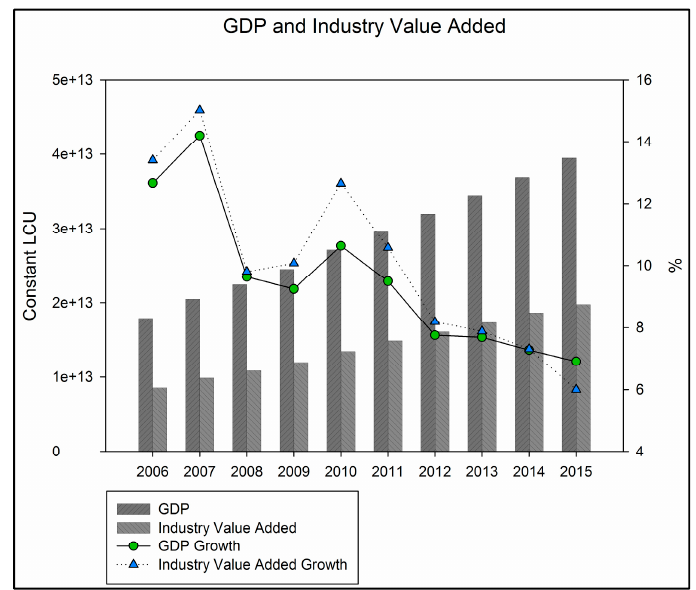
Figure 1. GDP and industry value-added in China from 2006 to 2015.